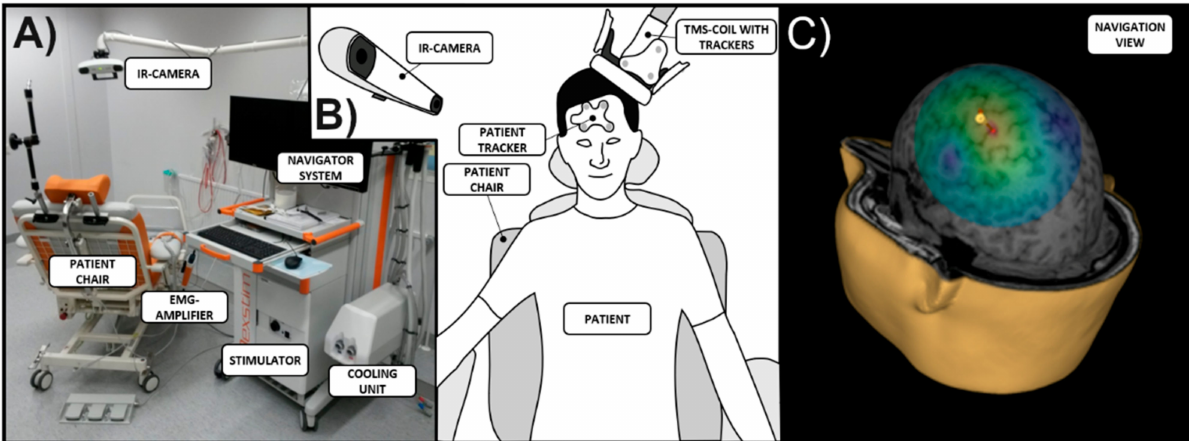
Figure 1. Setup for nTMS mapping. ( A ) Hardware of the nTMS system, including an infrared camera, EMG amplifier, neuronavigation monitor, and the stimulator with a cooling unit as the central components. ( B ) Patient positioning during mapping procedures, requiring initial co-registration of the patient’s head with cranial MRI (using a head tracker attached to the patient’s forehead) to be able to track the stimulating coil (equipped with infrared trackers) in relation to individual brain anatomy. ( C ) Navigation view during the mapping procedure, showing the stimulating coil ( yellow marker ) with its orientation ( red arrow ) and modelled EF